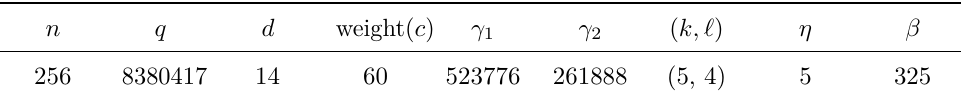
Table 1: Dilithium Parameter Set III (recommended)